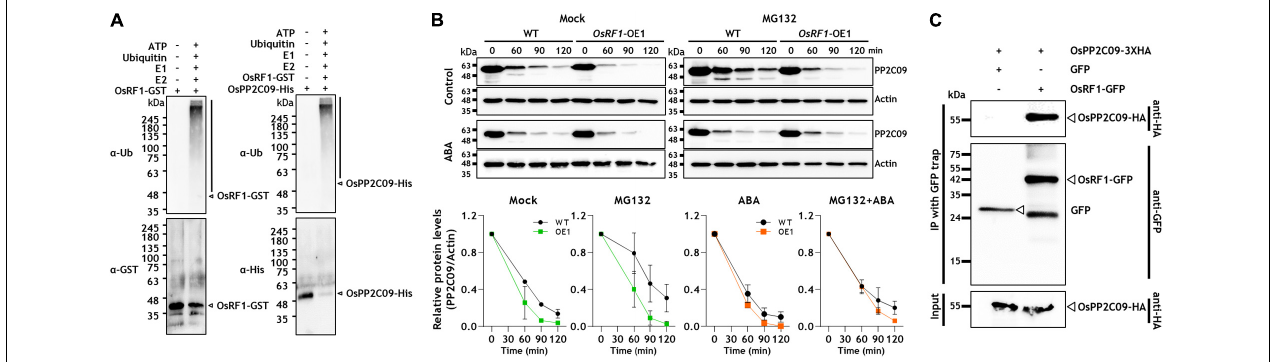
FIGURE 6 | OsRF1 mediates ubiquitination and degradation of OsPP2C09. (A) In vitro self-ubiquitination of OsRF1 and in vitro ubiquitination of OsPP2C09 by OsRF1. Purified OsRF1-GST was incubated with the OsPP2C09-His protein in the presence or absence of human E1, human E2, and bovine ubiquitin (Ub), and incubated at 30 ◦ C for 2 h. The reaction samples were mixed with a 5X SDS-PAGE loading buffer, resolved in SDS-PAGE, and immunoblotted with anti-ubiquitin, anti-GST, and anti-His antibodies. The polyubiquitinated proteins are indicated as black bars. (B) Cell-free degradation assay of OsPP2C09. Protein extracts were prepared from seedlings of wild-type and OsRF1 -OE lines treated with or without 100 µ M ABA and incubated with purified OsPP2C09-His at 28 ◦ C supplemented at indicated time points. Anti-His antibody was used to detect the OsPP2C09-His protein. Representative data from three independent experiments. Quantification of anti-OsPP2C09-His and anti-Actin signal intensity using the Image J software. The protein levels of OsPP2C09-His in WT or OsRF1 -OE extracts with indicated treatments at 0 min were set as 1. Data represent mean ( ± SD) from two independent experiments with three biological replicates ( n = 3). (C) Co-immunoprecipitation assay of OsPP2C09. The OsRF1-GFP fusion protein was co-expressed with the OsPP2C09-HA fusion protein in rice protoplasts. Total protein extracts from the transformed protoplasts were pull-downed with GFP-trap beads and detected by immunoblot using anti-HA antibody and anti-GFP